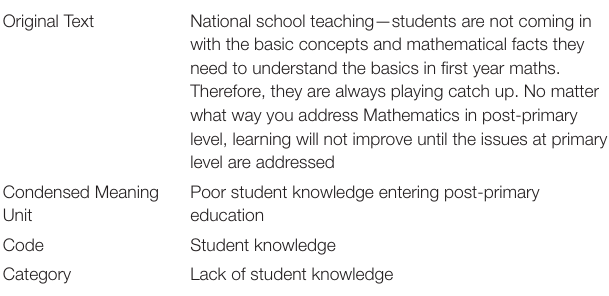
TABLE 2 | Example of analysis leading to generation of category/theme. Original